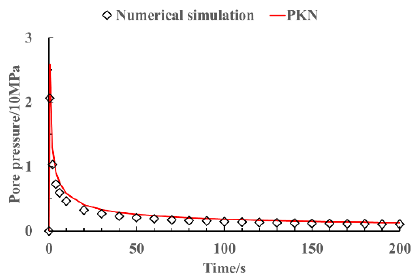
Figure 3. Results of pressure.